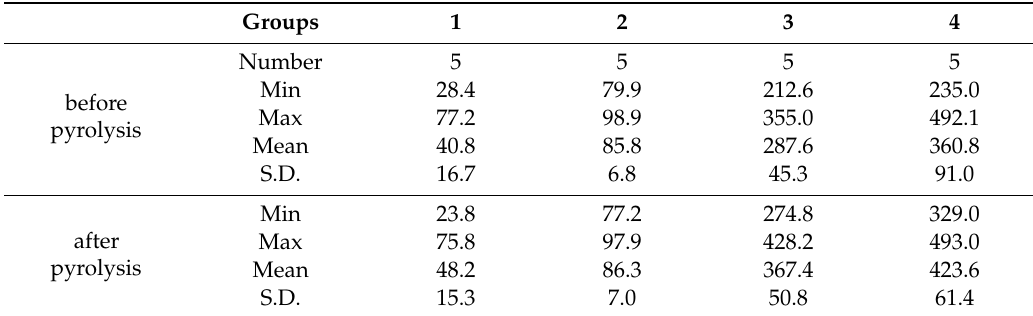
Table 1. Cadmium (Cd) content of lettuce leaves before and after pyrolysis obtained by atomic absorption spectrophotometer (AAS) (mg / kg). Groups Number before pyrolysis